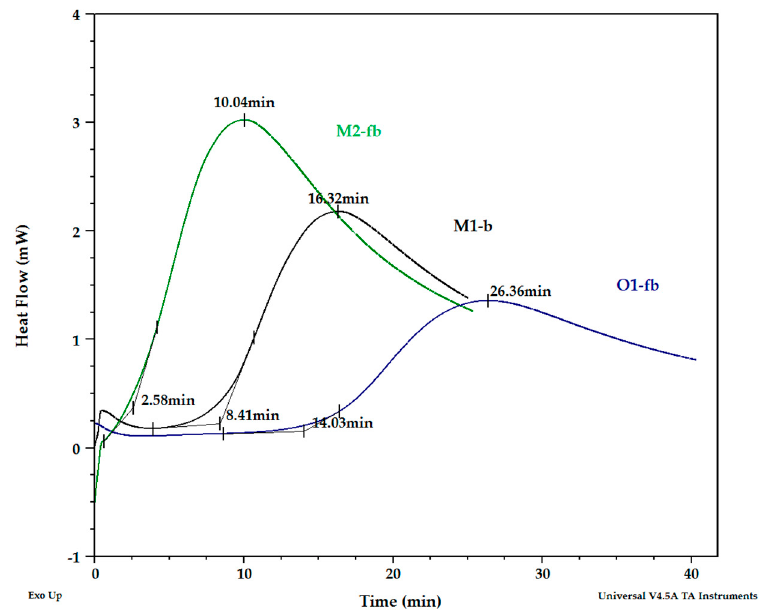
Figure 3. PDSC curves showing oxidation induction times T on and T max of cellular lipid samples from M1-b, M2-fb and O1-fb cultures.